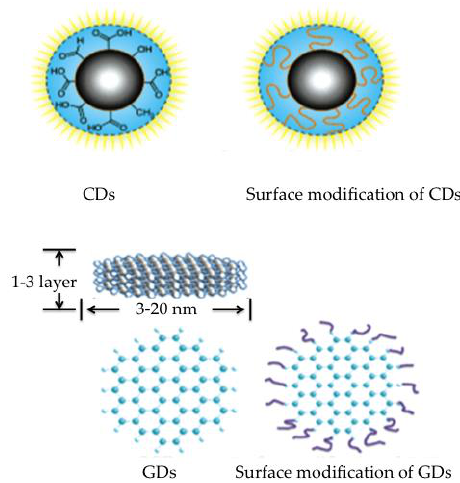
Figure 1. Illustration of CD (top) and GD (bottom) structures. Reproduced with permission of